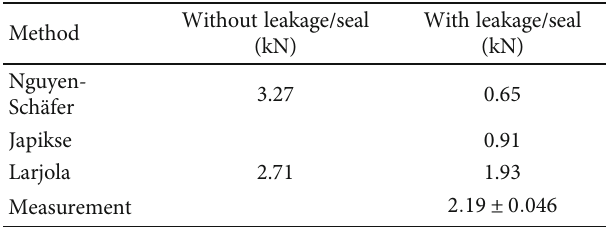
Table 8: Maximum axial thrust (point 9) estimated with three analytical methods and compared with the measured one. In Nguyen-Schäfer ’ s and Larjola ’ s methods, the leakage through the labyrinth seal can be either neglected or accounted